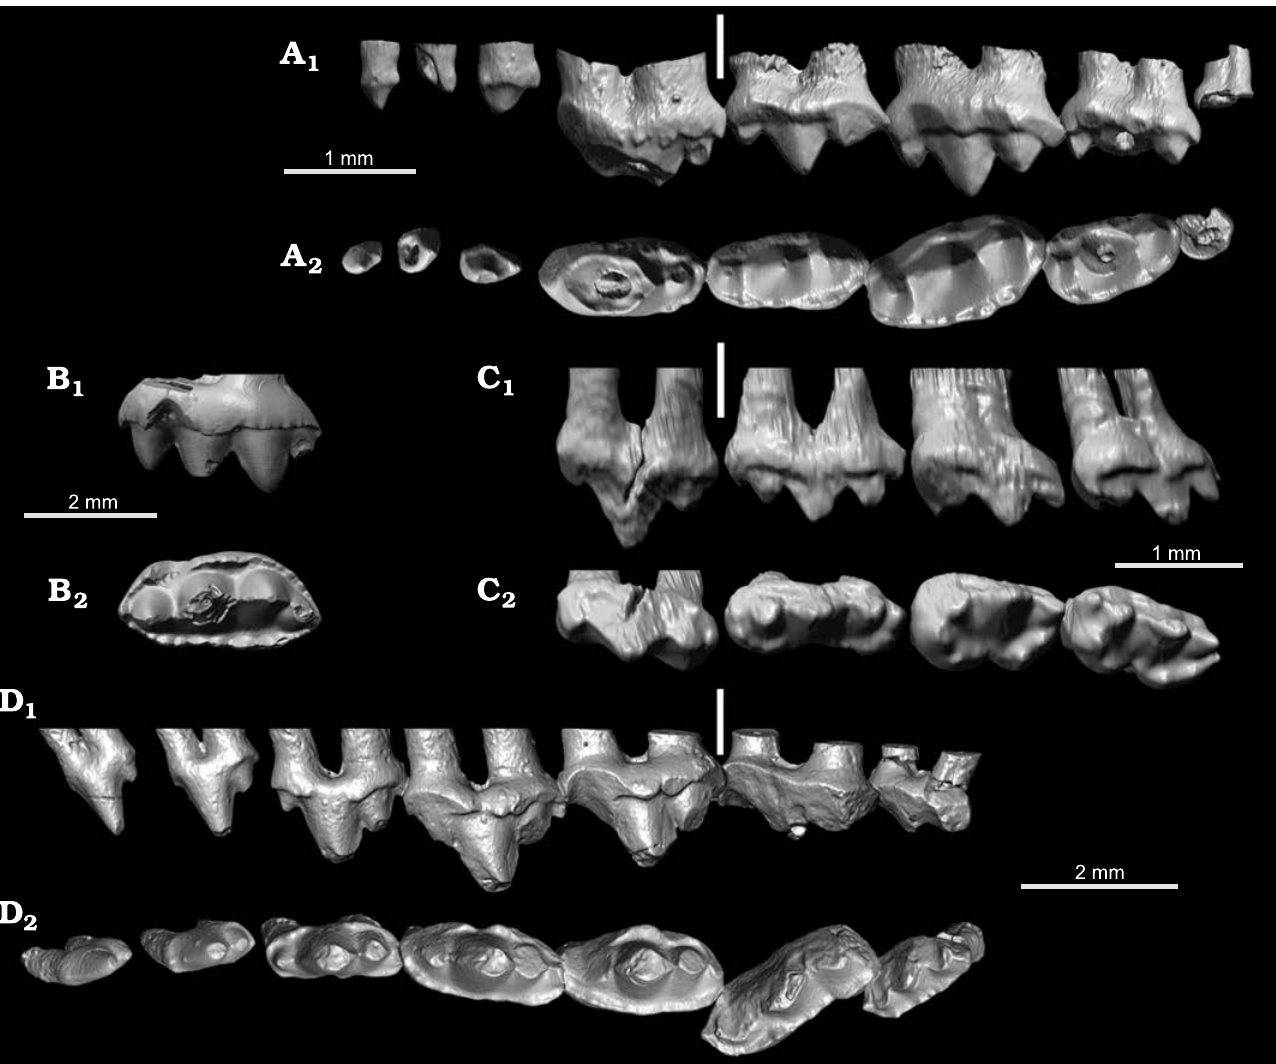
Fig. 6. Comparative 3D renderings of upper dentition of the morganucodontans Morganucodon watsoni Kühne, 1949 ( A , UMZC Eo.CR.1, reversed; Lower Jurassic fissure fills, Wales, UK), Storchodon cingulatus Martin, Averianov, Jäger, Schwermann, and Wings, 2019 ( B , NLMH 105654; Upper Jurassic Süntel Formation, Germany), Megazostrodon rudnerae Crompton and Jenkins, 1968 ( C , NHMUK PV M 26407; Lower Jurassic Stormberg Group, Lesotho), and Cifellilestes ciscoensis gen. et sp. nov. ( D , OMNH 80538, holotype; Upper Jurassic Morrison Formation, USA), in lingual (A 1 –D 1 ) and occlusal (A 2 –D 2 ) views. White lines indicate the premolar–molar boundary (all taxa except Storchodon , which is known by only a single molar). This boundary is marked by a tall-crowned ultimate premolar with much lower flanking cusps followed by a first molar that is comparatively lower crowned with less height difference between the main cusps. Note imbrication of the molars in C. ciscoensis gen. et sp. nov. (D 2 ) and distal molars in Mo. watsoni (A 2 ), a feature absent in Me. rudnerae (C 2